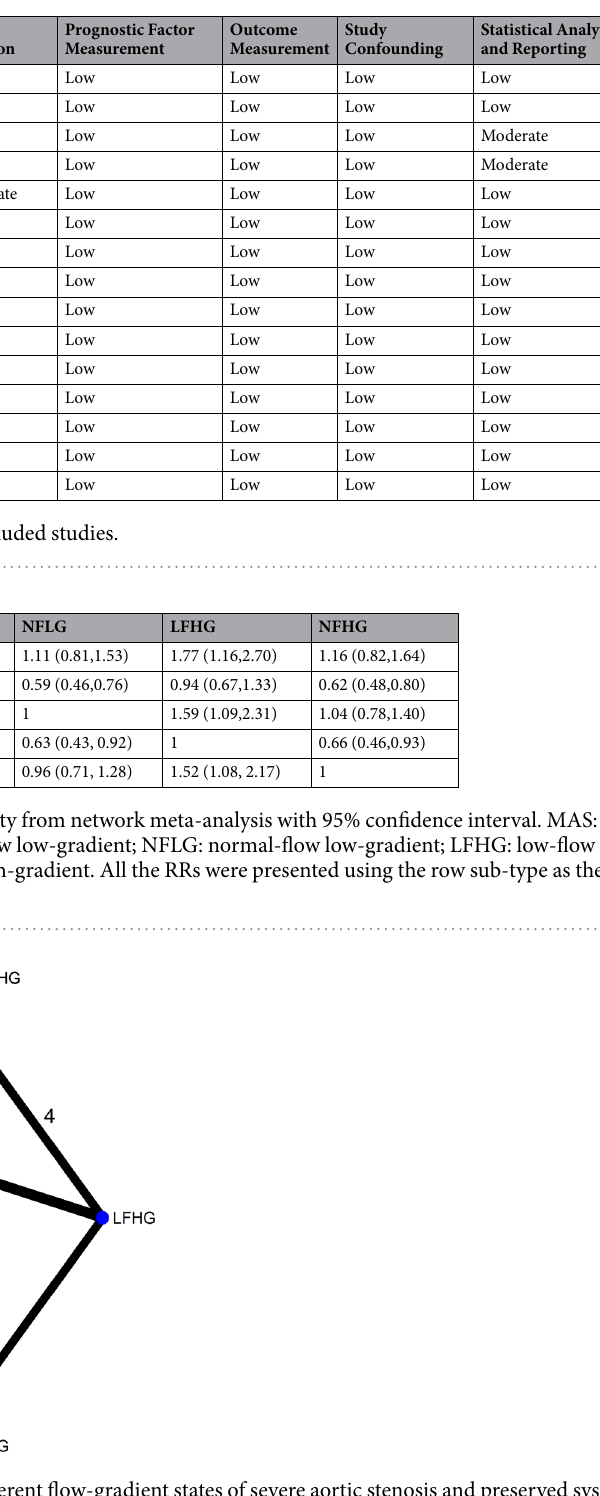
Figure 2. Network geometry of the different flow-gradient states of severe aortic stenosis and preserved systolic ejection fraction.